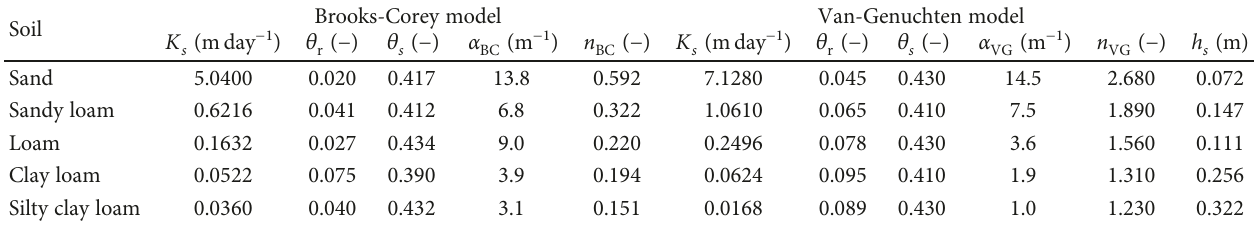
Table 2: Parameter sets of 5 typical soils in the Brooks-Corey model and the van-Genuchten model. Brooks-Corey Soil